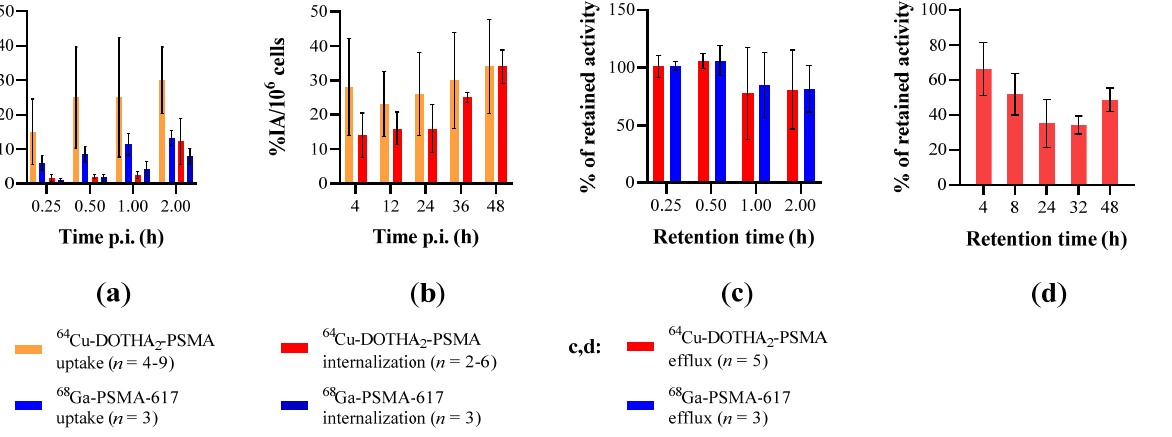
Figure 1. 64 Cu-DOTHA 2 -PSMA cellular uptake and internalization ( a ) in comparison with 68 Ga- PSMA-617 up to 2 h p.i. and ( b ) without comparison, up to 48 h p.i. ( c ) 64 Cu-DOTHA 2 -PSMA retention in comparison with 68 Ga-PSMA-617 up to 2 h p.i. and ( d ) up to 48 h p.i. in human adenocarcinoma cells expressing PSMA (LNCaP). 68 Ga-PSMA-617’s uptake up to 2 h p.i. was significantly lower than 64 Cu-DOTHA 2 -PSMA’s (a, p < 0.001), with no significant difference in internalization and efflux.